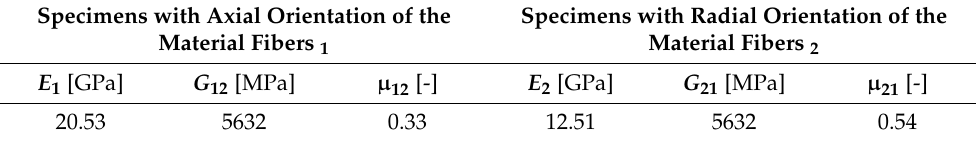
Table 5. Statistically processed and evaluated material characteristics of test